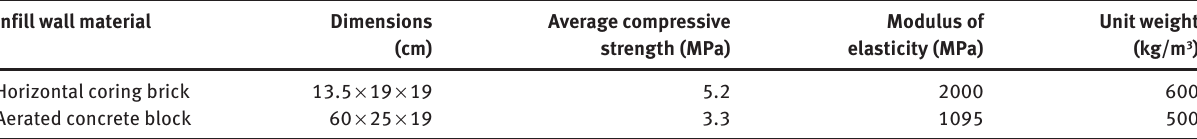
Table 3: Some mechanical and physical properties of brick and aerated concrete